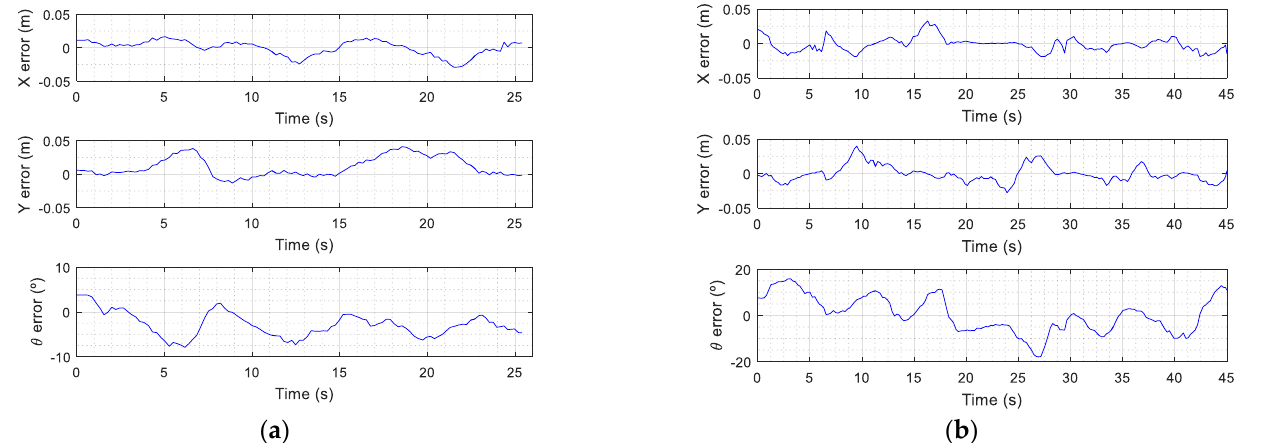
Figure 8. Error location ( x e , y e , θ e ) when the mobile robot moves at a constant translational velocity of 0.15 m/s: ( a ) following a circular trajectory with the robot facing inward and ( b ) following an eight-shaped trajectory with the robot facing forward. Table 1. Path-tracking errors obtained in the case of performing a circular target trajectory (Figure 7a).